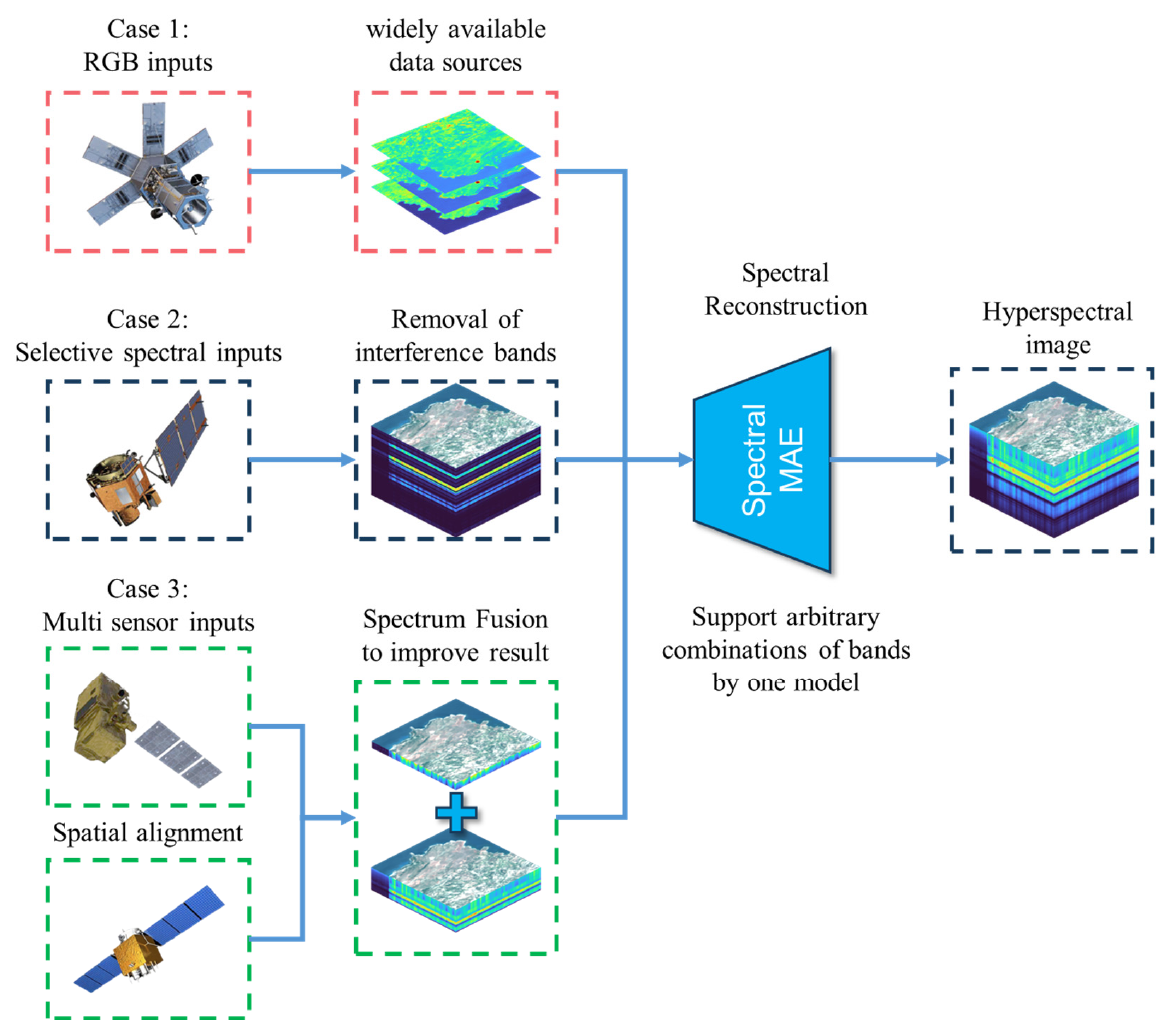
Figure 2. Typical application scenarios for SpectralMAE.